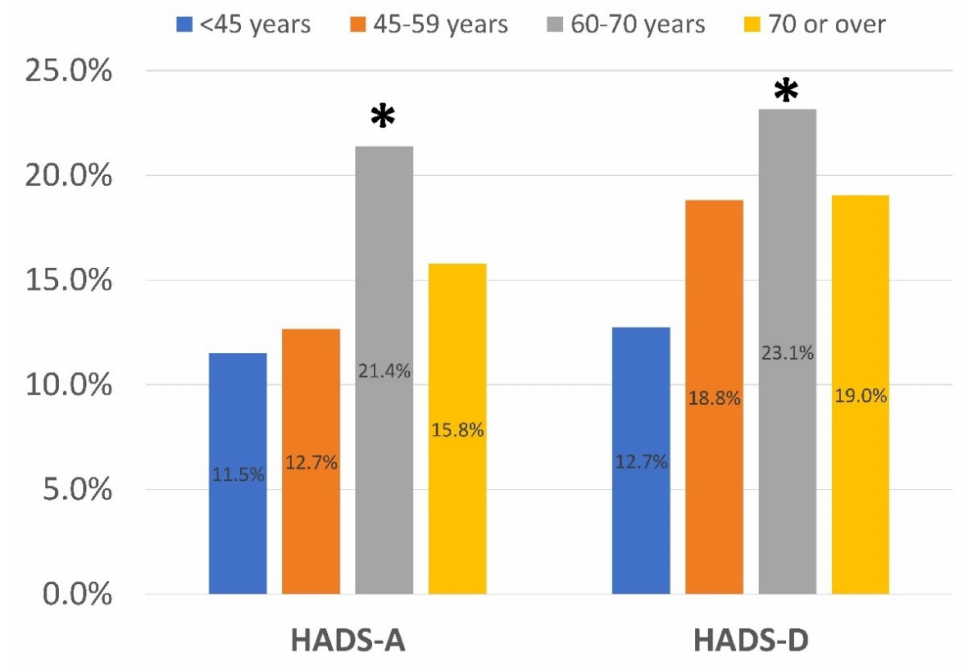
Figure 2. Distribution of the percentage of individuals exhibiting anxiety (HADS-A ≥ 8 points) and depressive (HADS-D ≥ 8 points) symptoms according to the Hospital Anxiety and Depression Scale (HADS) by age group. * Significant differences by age group ( p <